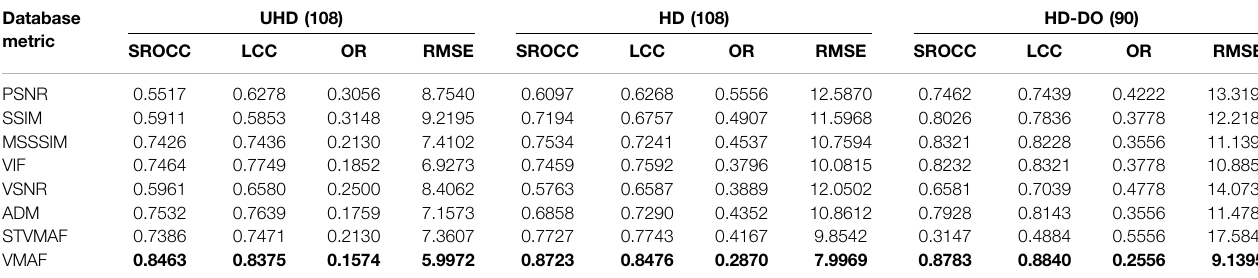
TABLE 7 | The correlation statistics of six popular quality metrics when evaluated on three subject datasets (UHD, HD and HD-DO). Database metric